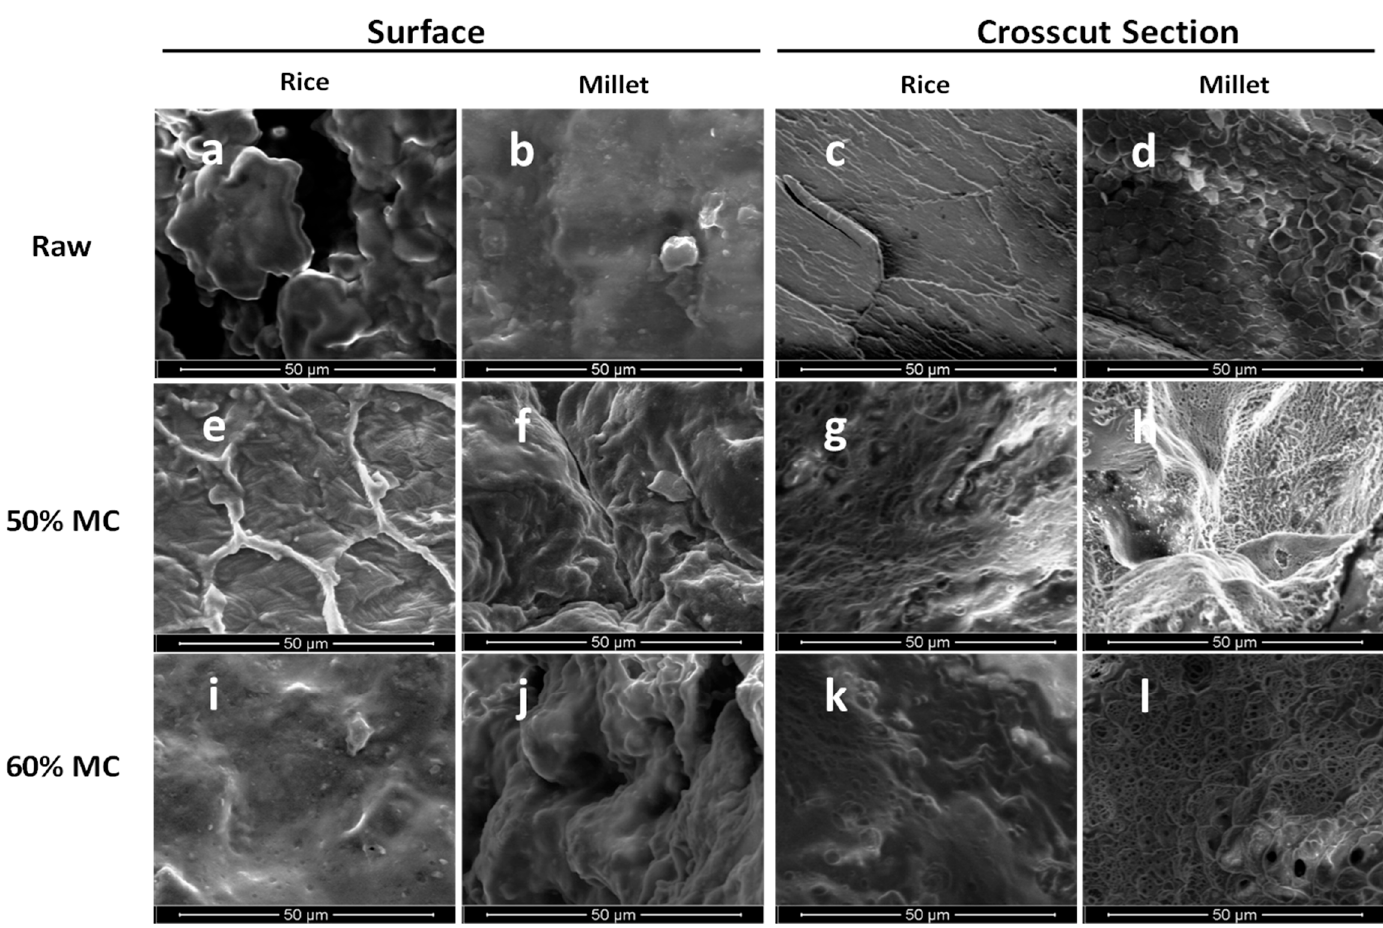
Figure 4. SEM imaging of raw and autoclaved moist parboiled rice and millet.